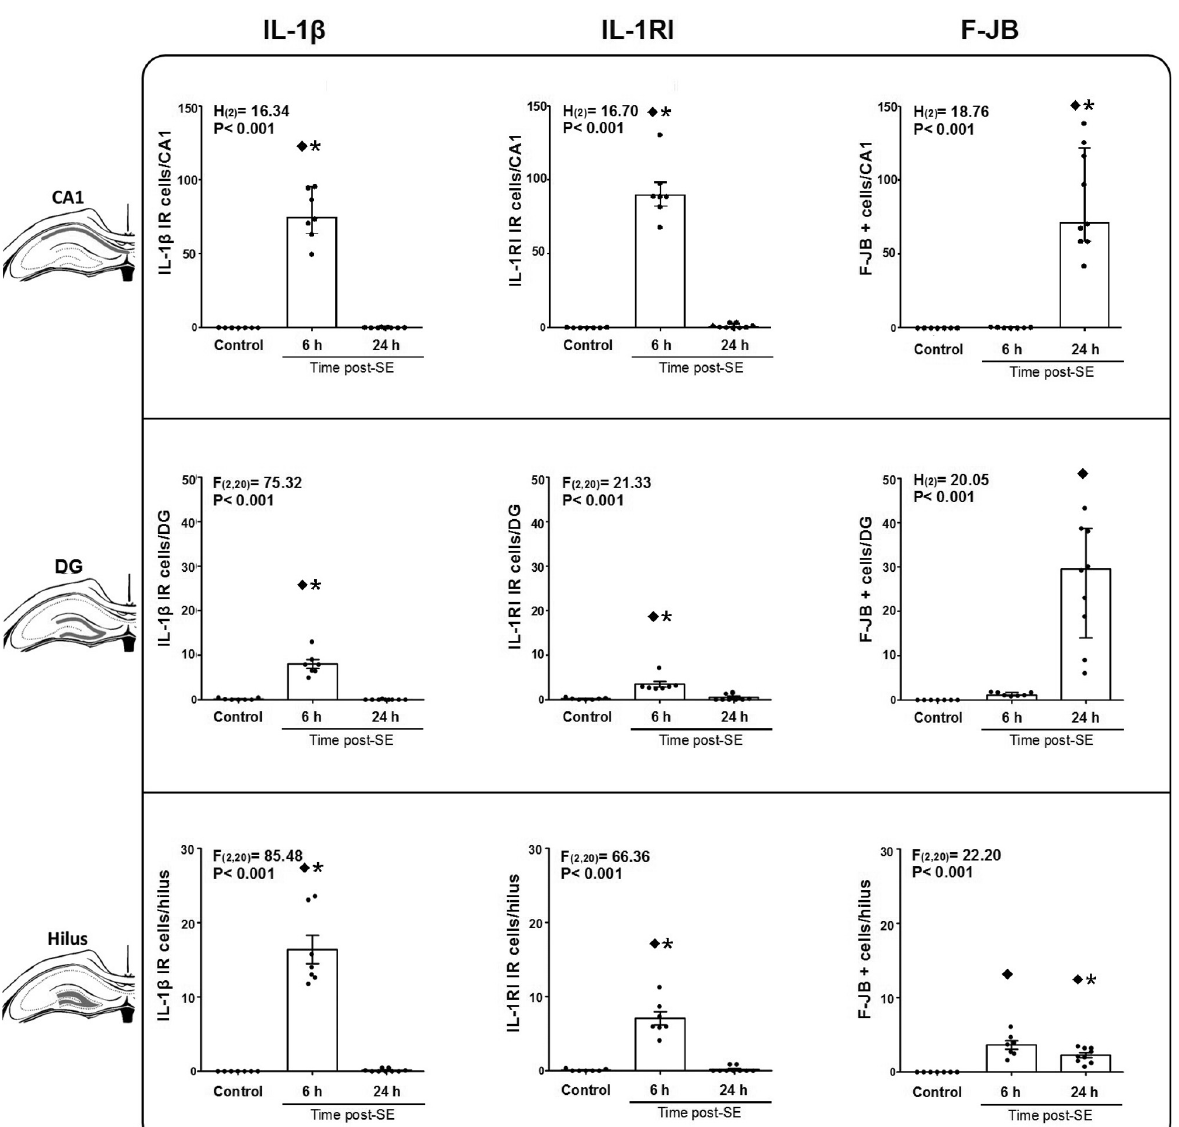
Figure 2 - Interleukine-1 β (IL-1 β ), type 1 IL-1 receptor (IL-1RI) and Fluoro-Jade B (F-JB) positive cells detected in the CA1 pyramidal layer, dentate gyrus (DG) granule cell layer and hilus from dorsal hippocampus 6 h and 24 h after status epilepticus (SE) or control conditions. Data are shown as the mean ± S.E.M. or medians and interquartile range (F-JB positive cells in CA1 and DG) and were analysed by an one-way ANOVA followed by a Tukey test or by a Kruskal–Wallis one-way ANOVA followed by a Dunn’s test. ♦ p<0.01 Vs control; *p<0.001 Vs